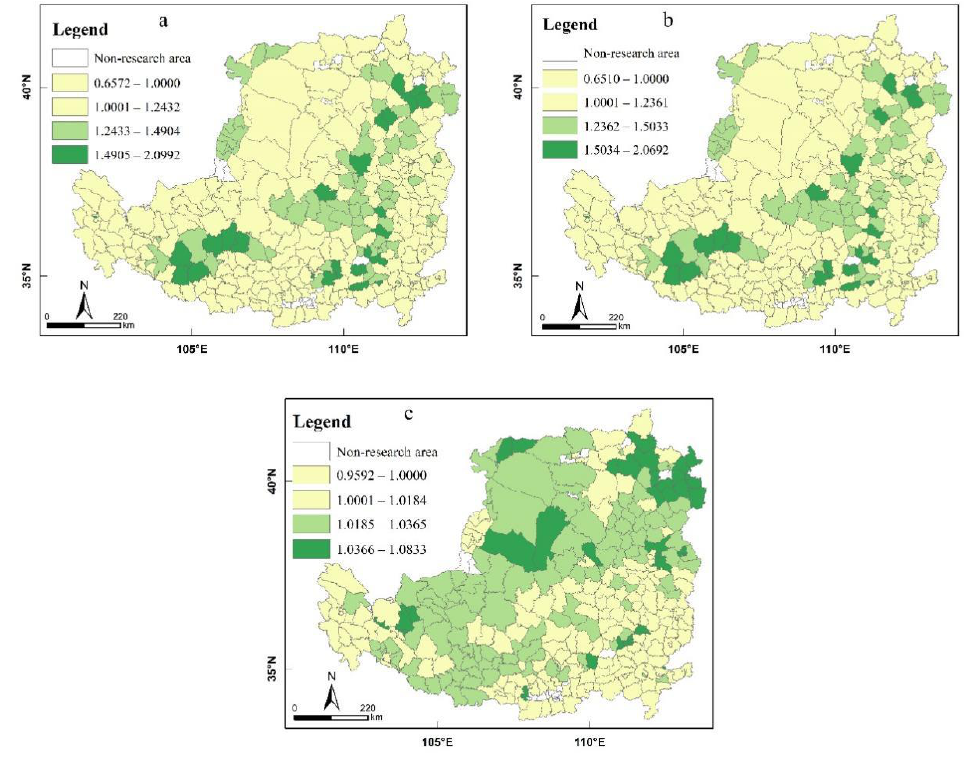
Figure 6. The average value of (a) MI, (b) EFCH, and (c) TECH for 314 counties from 2002 to